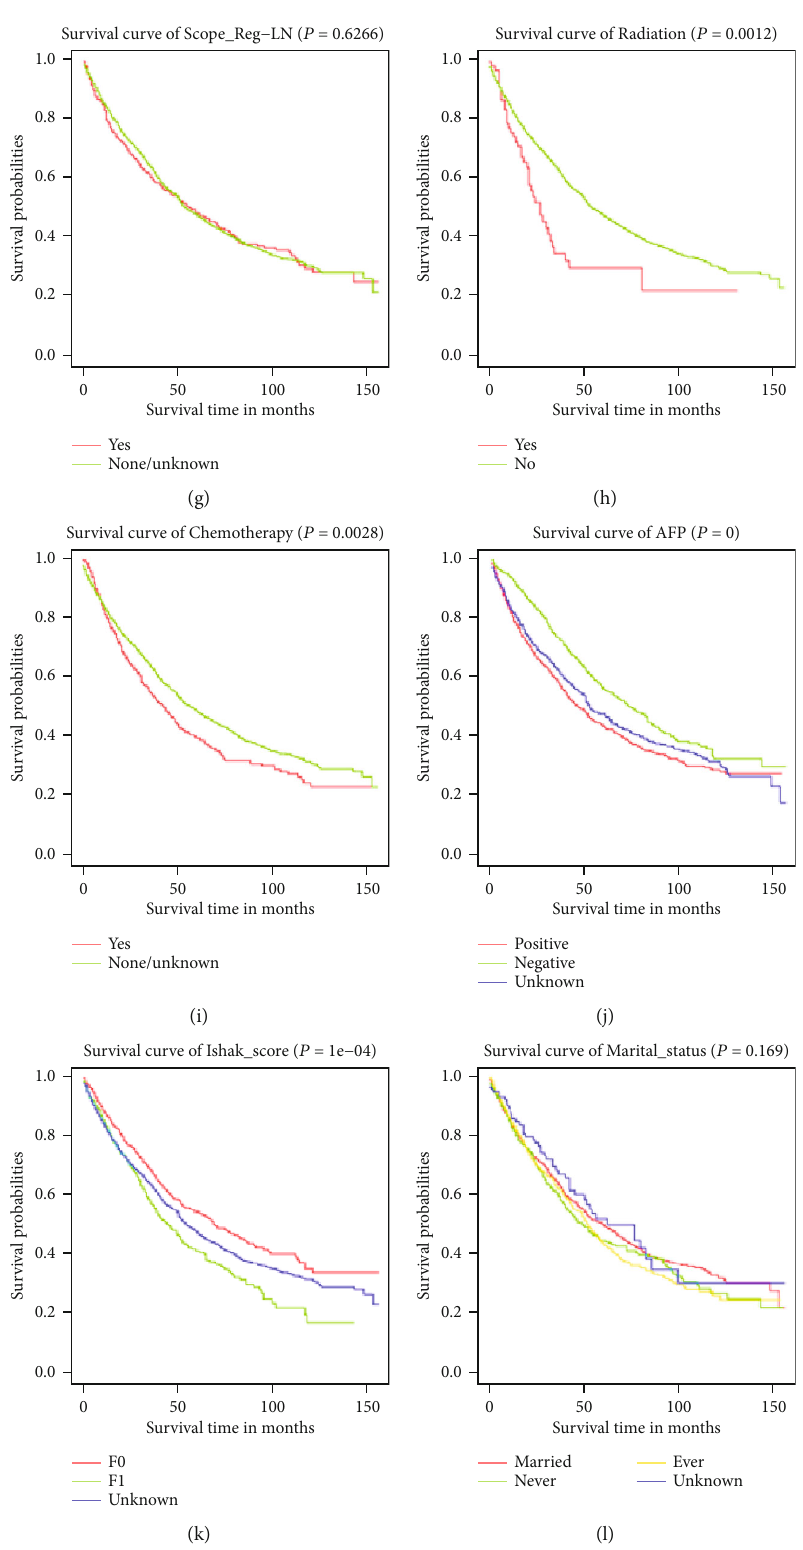
Figure 2: Kaplan-Meier survival curves of the derivation cohorts generated for relative risk factors. (a – l) Possible correlations between Survival and 13 risk factors (Age, Sex, Race, Grade, AJCC_8, Tumor_size, Surg_size, Scope_Reg-LN, Radiation, Chemotherapy, AFP, Ishak_score, and Marital_status). All using univariate Cox